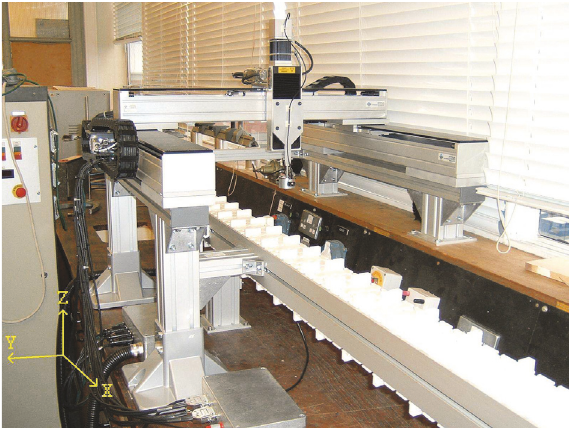
Figure 3: Gantry robot benchmark